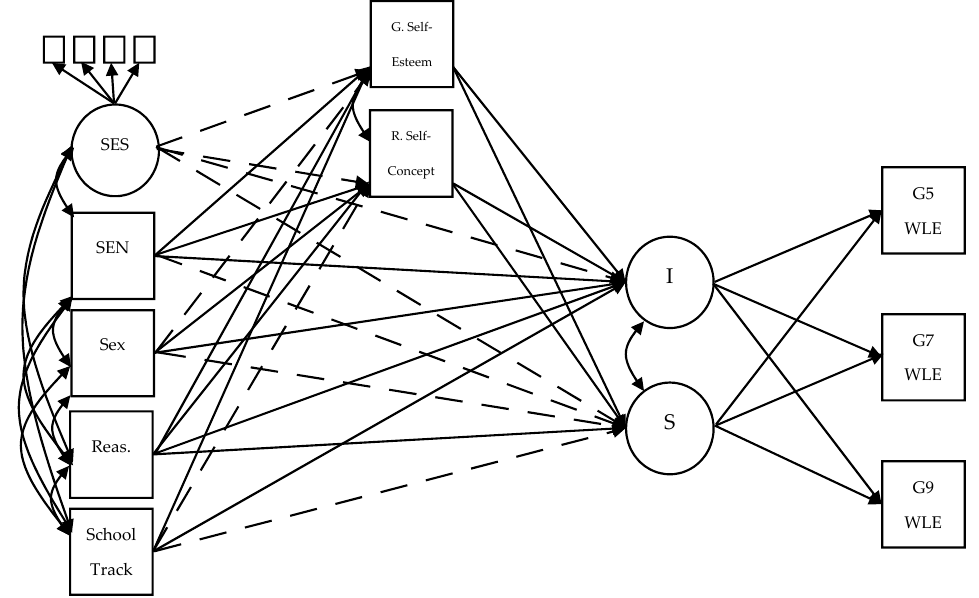
Figure 4. Mediation Model—Reading. This figure describes all pathways used in the mediation model. The no mediation model was calculated by zeroing out regressions from and onto the mediators. Solid lines indicate significant path, and dashed lines indicate non-significant paths. G5 WLE, G7 WLE, and G9 WLE refer to grade 5, 7, and 9 weighted likelihood estimates (WLE), respectively. I refers to intercept. S refers to slope. R. Self-concept refers to readings self-concept. G. Self- Esteem refers to global self-esteem. SES refers to socioeconomic status. SEN refers to special education needs. Reas. refers to nonverbal reasoning